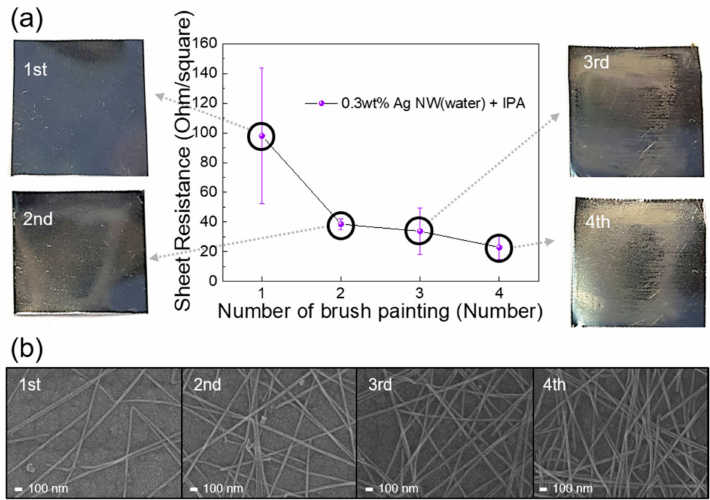
Figure 3. ( a ) Sheet resistance of brush-painted Ag NWs electrode on SiO 2 coated invar substrate with an increasing number of brush painting process. Surrounding sample pictures show the change of surface image according to the number of brush painting. ( b ) Surface field emission SEM (FESEM) images of brush painted Ag NW network with increasing number of brush